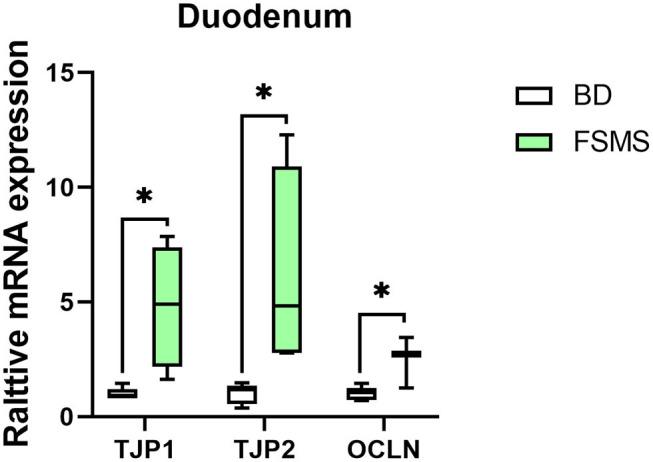
Influence of FSMS addition on the tight junction transmembrane protein, tight junction protein 1 (TJP1), tight junction protein 2 (TJP2), and occludin (OCLN) mRNA expression. *p < 0.05, **p < 0.01.